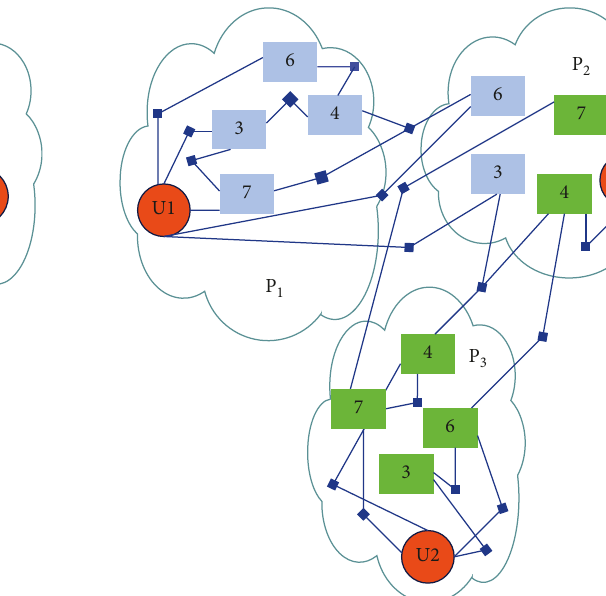
Figure 5: Results of hypergraph repartitioning ( α